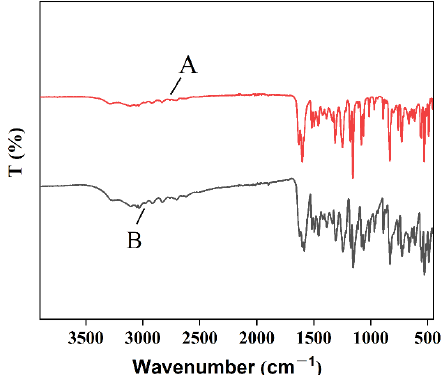
Figure 6. Comparison of raw naringenin ( A ) and NUP ( B ) under FTIR conditions.